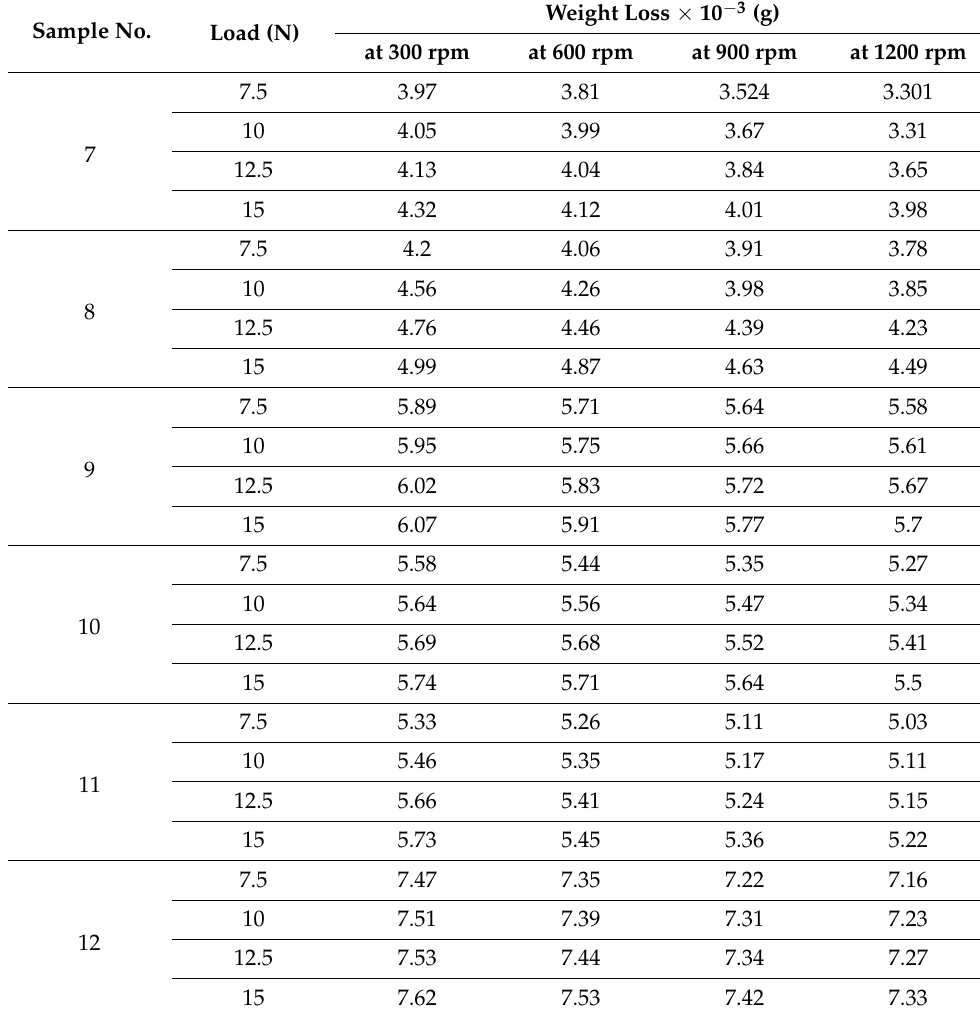
Table 5. Cont. Sample